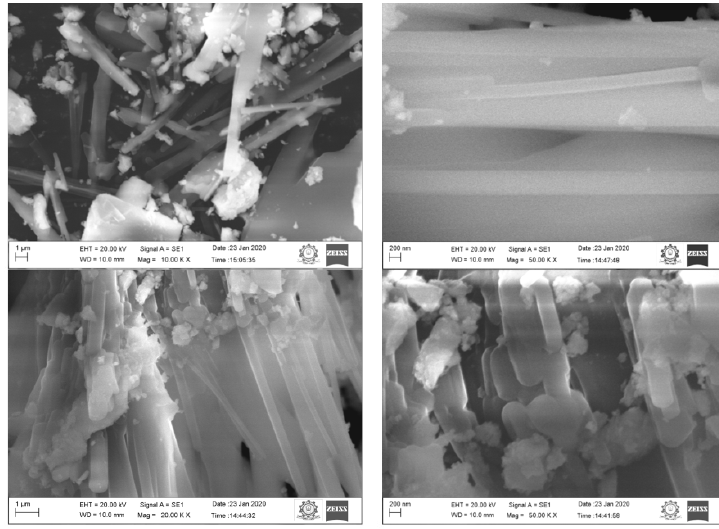
Fig. 2. SEM images of Zirconia with different magnifications